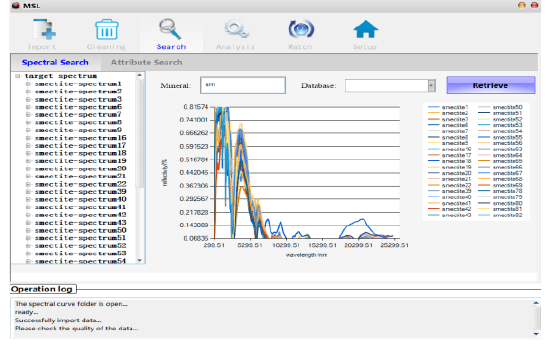
Figure 11. The data search interface